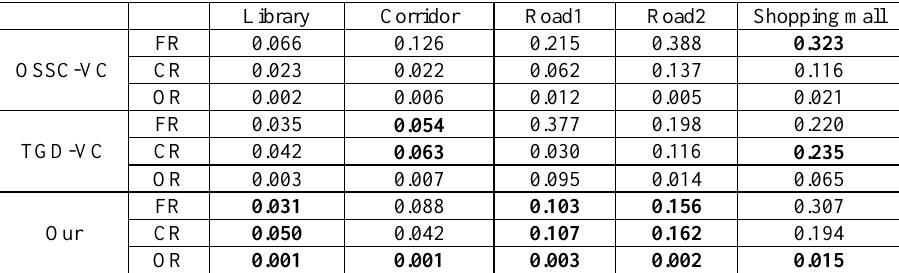
Table 2. Comparison of video synopsis